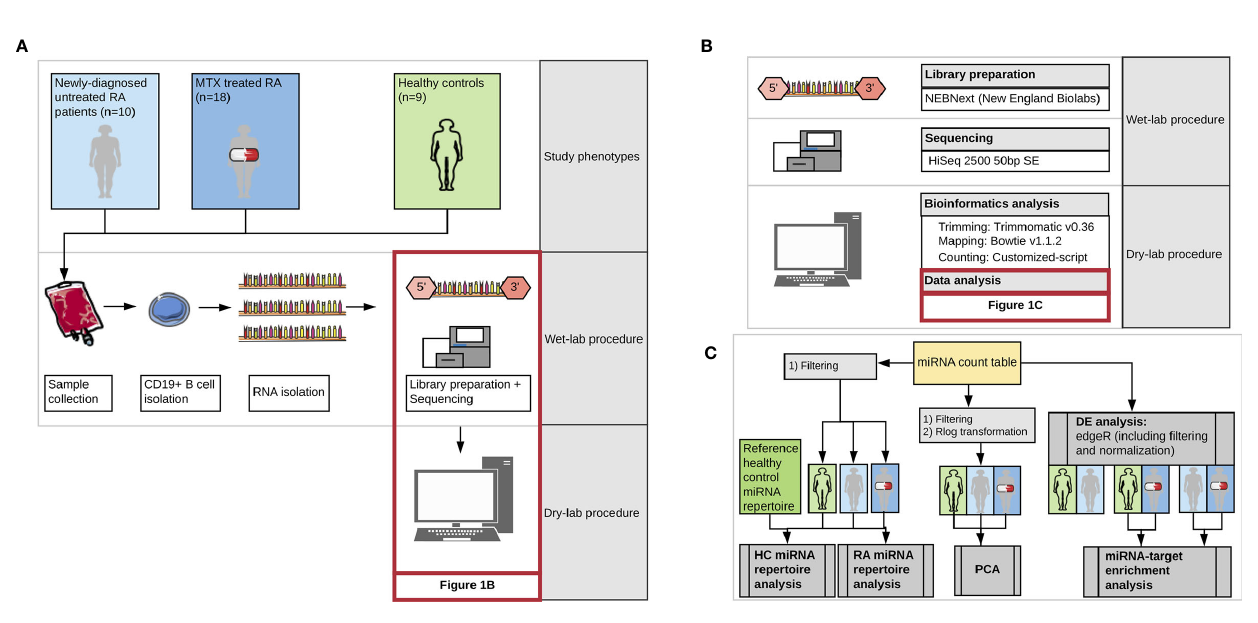
FIGURE 1 | Work fl ow of the study representing (A) the three study phenotypes and major steps during wet-lab and computational analysis, (B) detailed representation of the kit, technology and tools used during miRNA library preparation, sequencing and bioinformatics analysis, and (C) detailed presentation of the steps included in the data analysis. DE, differential expression analysis; MTX, Methotrexate; HC, healthy controls. Images from Servier Medical Art (Servier. www. servier.com, licensed under a Creative Commons Attribution 3.0 Unported License) were used in the fi